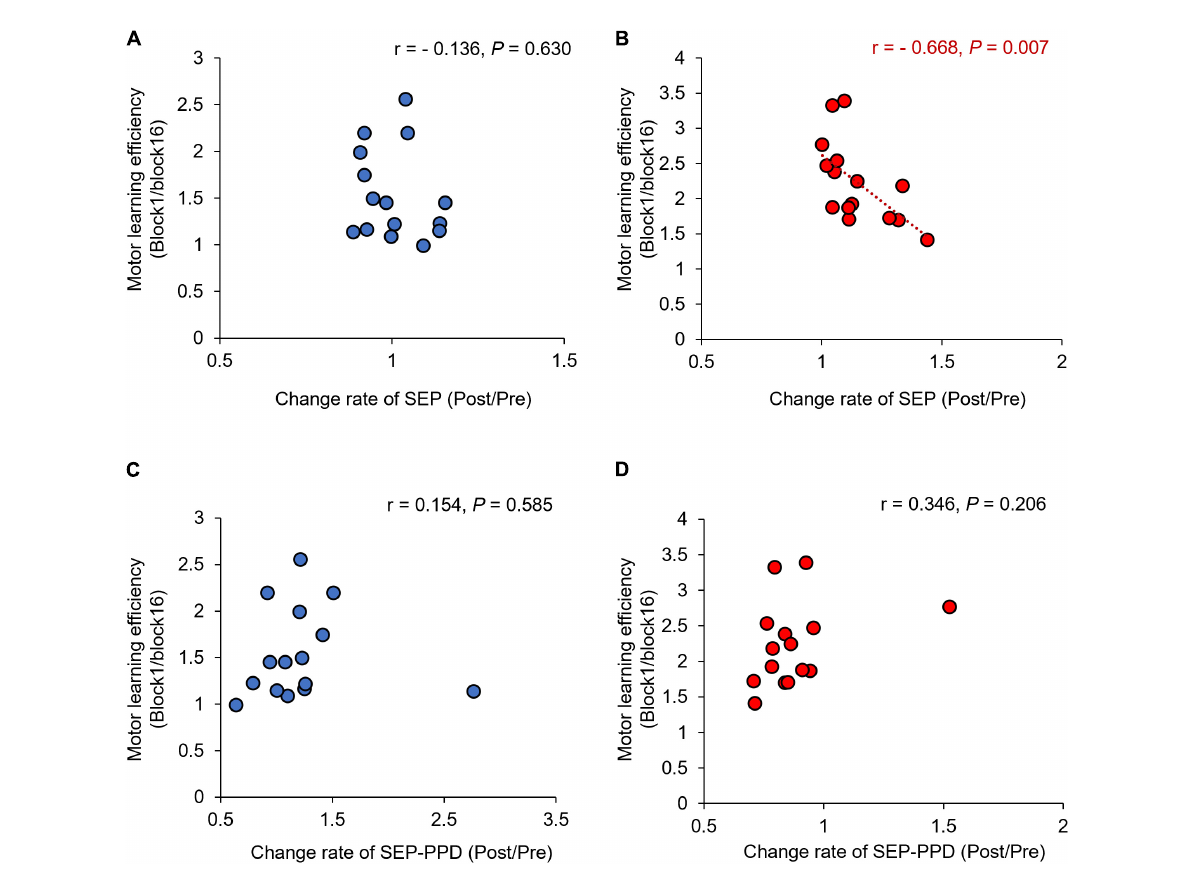
FIGURE9 Correlations between change rates of SEP, SEP-PPD, and motor learning efficiency under each condition. The blue circles represent the correlation between the change rate of SEP and SEP-PPD and the motor learning efficiency in the simple visuomotor task (A,C) . The red circles represent the correlation between the change rate of SEP and SEP-PPD and the motor learning efficiency in the complex visuomotor task (B,D) . In the complex visuomotor task alone, there was a significant correlation between the change rate of SEP and motor learning efficiency ( r = − 0.668, df = 13, p =